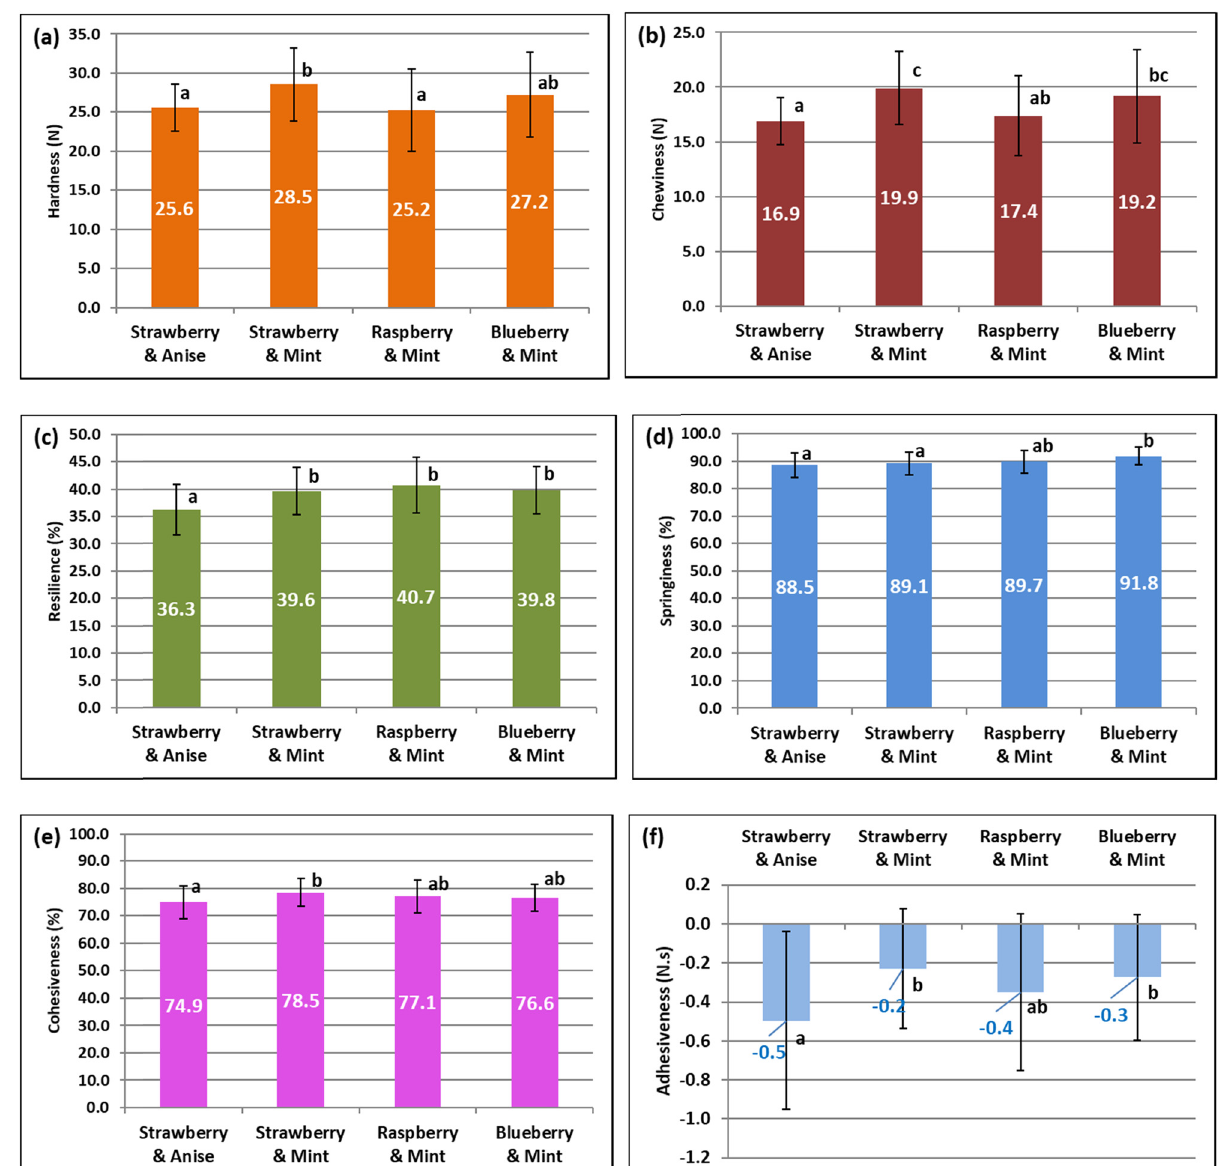
Figure 4: Textural properties of the jelly gums as a whole, obtained by the compression test: ( a ) hardness, ( b ) chewiness, ( c ) resilience, ( d ) springiness, ( e ) cohesiveness and ( f ) adhesiveness ( bars with the same letter are not statistically di ff erent at 5% signi fi cance level – ANOVA with Tukey test )